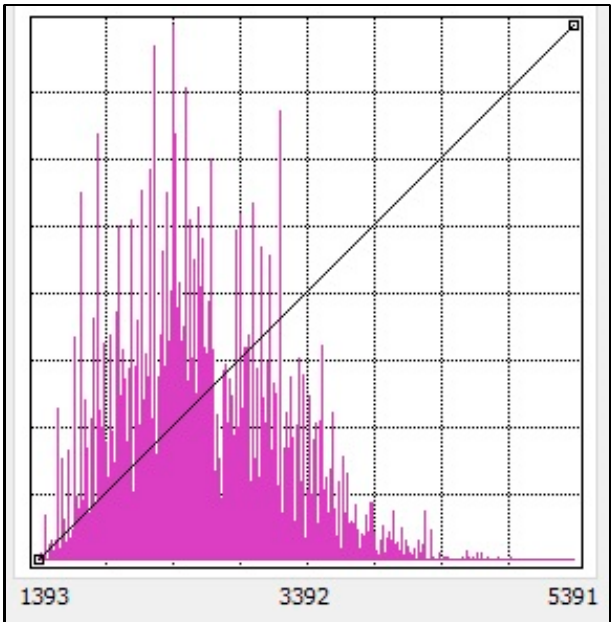
Figure 8. Histogram analysis of the LSM model.